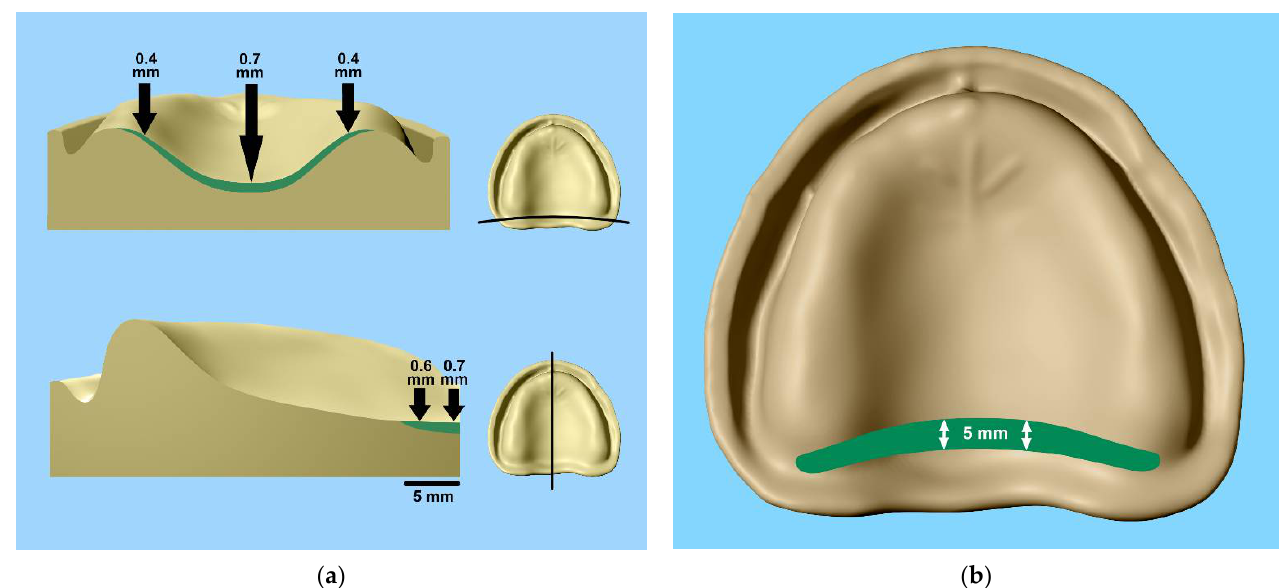
Figure 5. ( a ) Suggested shapes of the scraping at the tuberae maxillae at the midline palatal area (view from dorsal and sagittal); ( b ) suggested shape of the scraping at the posterior palatal seal (view from above the upper jaw cast).